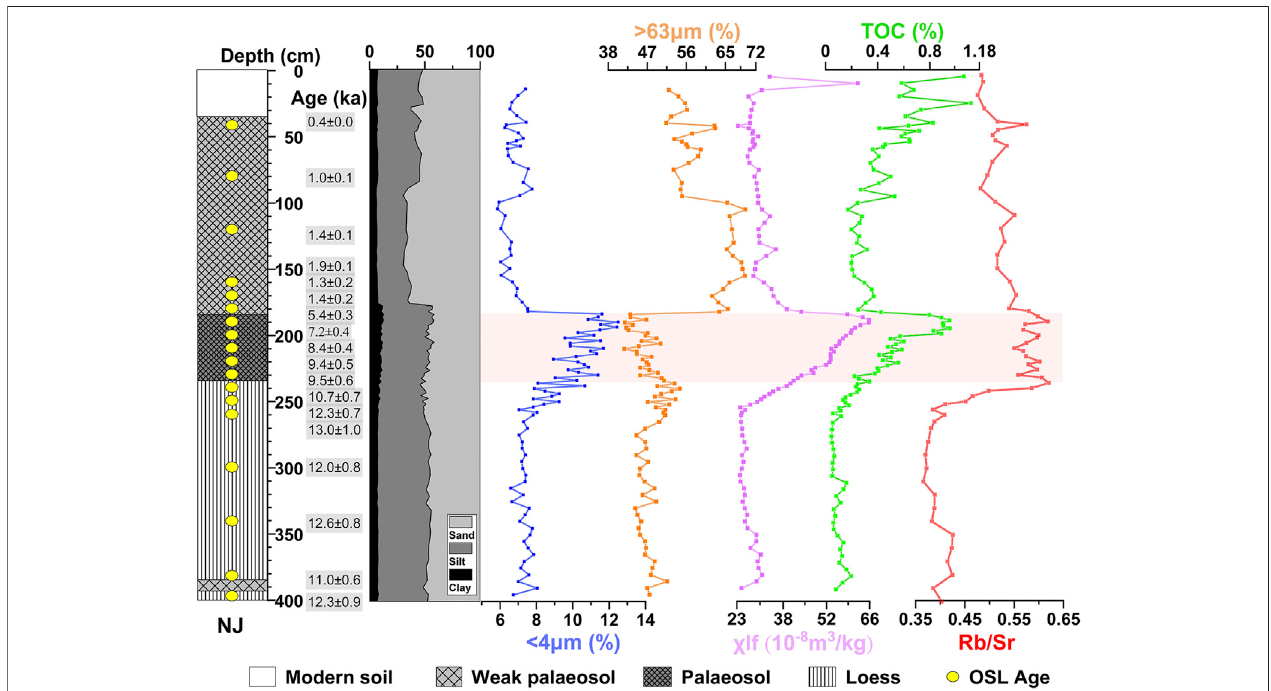
FIGURE 6 | Stratigraphic sequence of the NJ section showing OSL ages and variations in sediment size and various proxy indicators with depth.